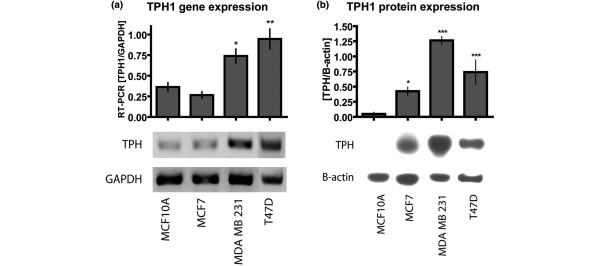
TPH1 expression in non-transformed and breast cancer cells. (A) Bar graphs representing TPH1 mRNA levels in indicated cell lines as detected by semi-quantitative RT - PCR reactions and normalized to GAPDH. Shown below is a representative picture of resulting PCR reactions. (B) Bar graphs and electophoretic bands showing TPH1 protein levels in the extracts of indicated cells normalized to β-actin. Error bars in (A) and (B) represent ± SEM. *P < 0.05, **P < 0.01 and ***P < 0.001 (one-way ANOVA) in comparison to MCF10A cells.